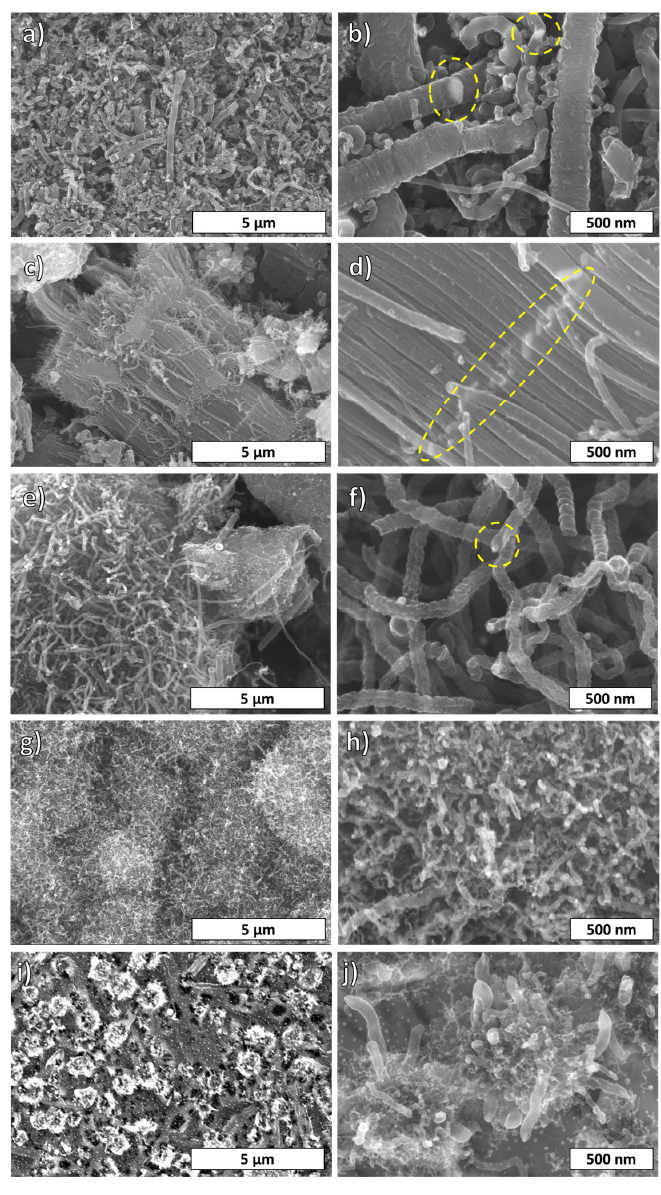
Figure 3. SEM micrographs of carbon fibers grown by ( a , b ) benzene, ( c , d ) dichlorobenzene, ( e , f ) NMP, ( g , h ) ethanol, and ( i , j ) methanol SPGS. Ni content at joints and tips is highlighted in yellow